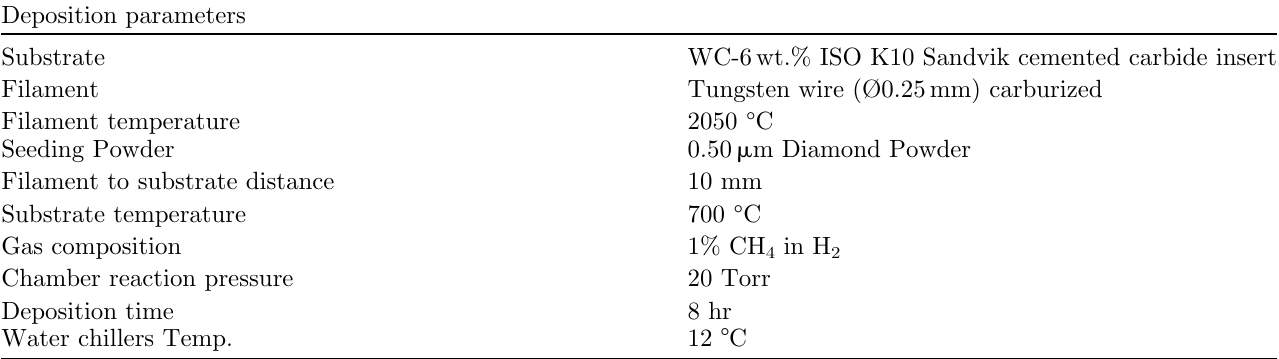
Table 1. Deposition condition. Deposition